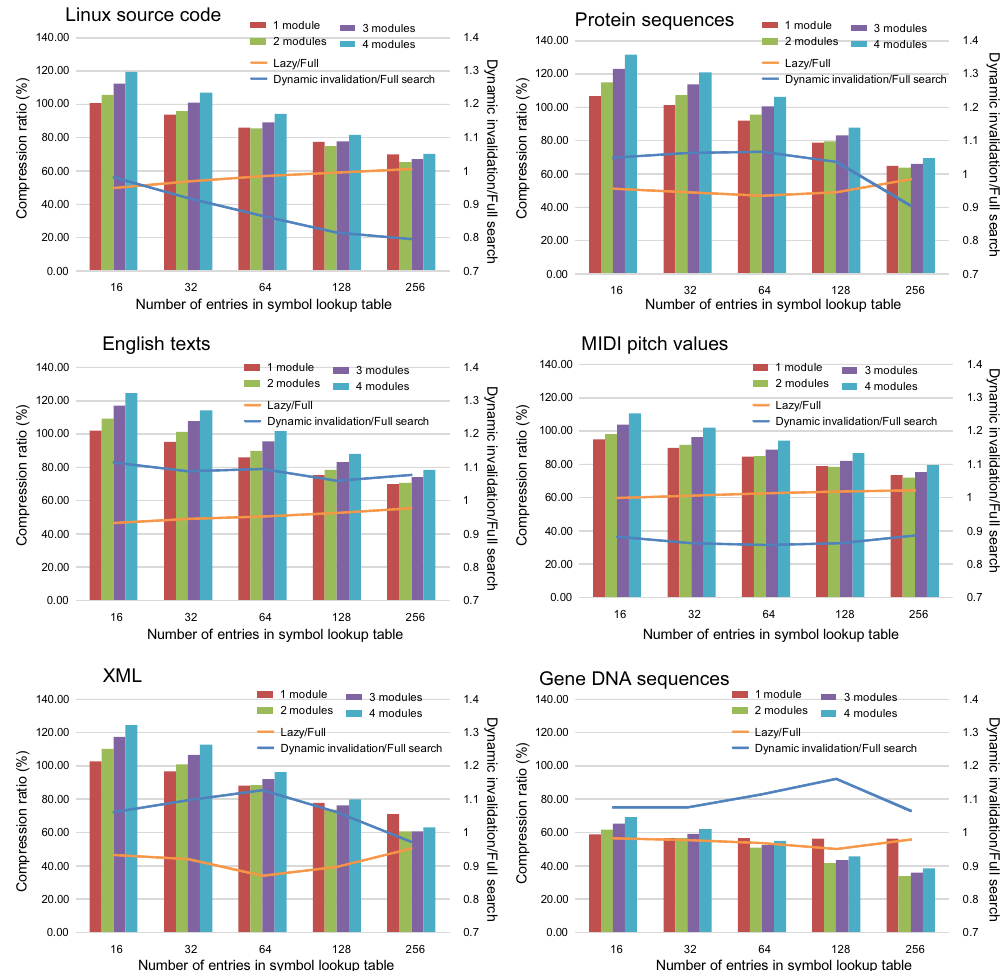
Figure 11. Compression ratios of LCA-DLT with the dynamic invalidation and with the full search